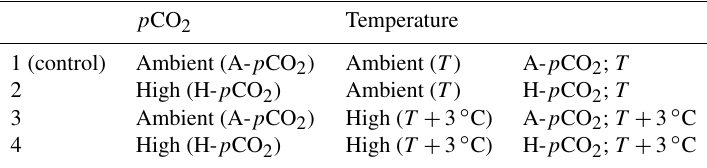
Table 1. Summary of the four experimental treatments. Two p CO 2 (ambient and high p CO 2 ) and temperature (ambient and high tem- perature) conditions were tested. High p CO 2 (H- p CO 2 ) corresponded to a pH decrease of − 0.33 units compared to ambient conditions (A- p CO 2 ) . High temperature ( T + 3 ◦ C) corresponded to a temperature increase of 3 ◦ C compared to ambient conditions ( T